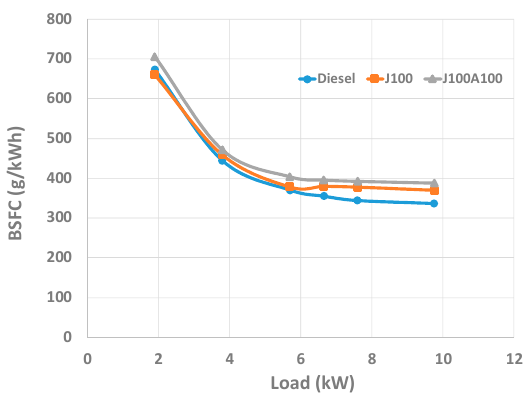
Figure 3. BSFC vs. engine load.